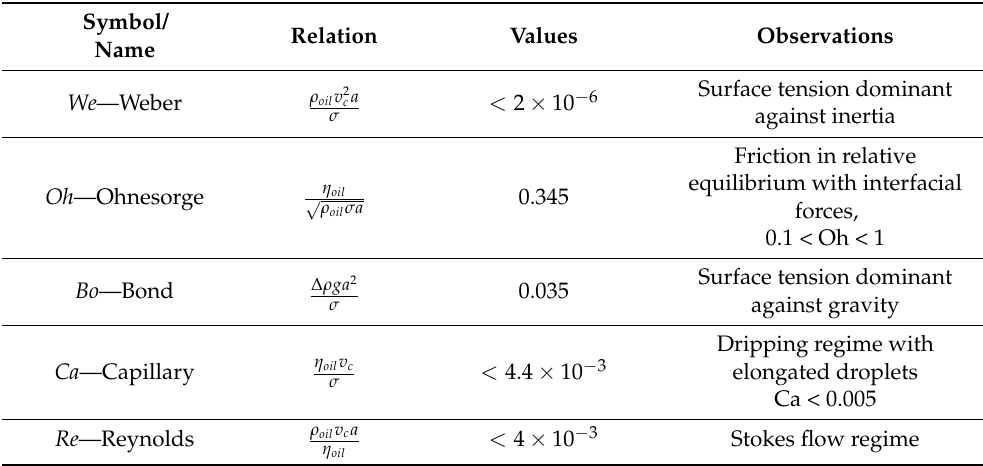
Table 2. Nondimensional numbers computed with the material properties of the primary phase (oil); here, v c = Q oil / a 2